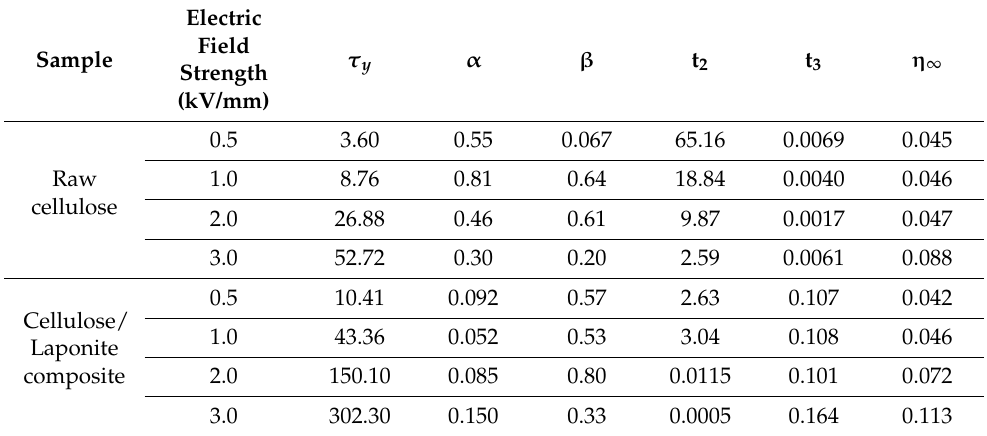
Table 1. The fitting parameters of the Cho–Choi–Jhon (CCJ) model to the flow curves of raw cellulose ER fluid and cellulose/Laponite ER